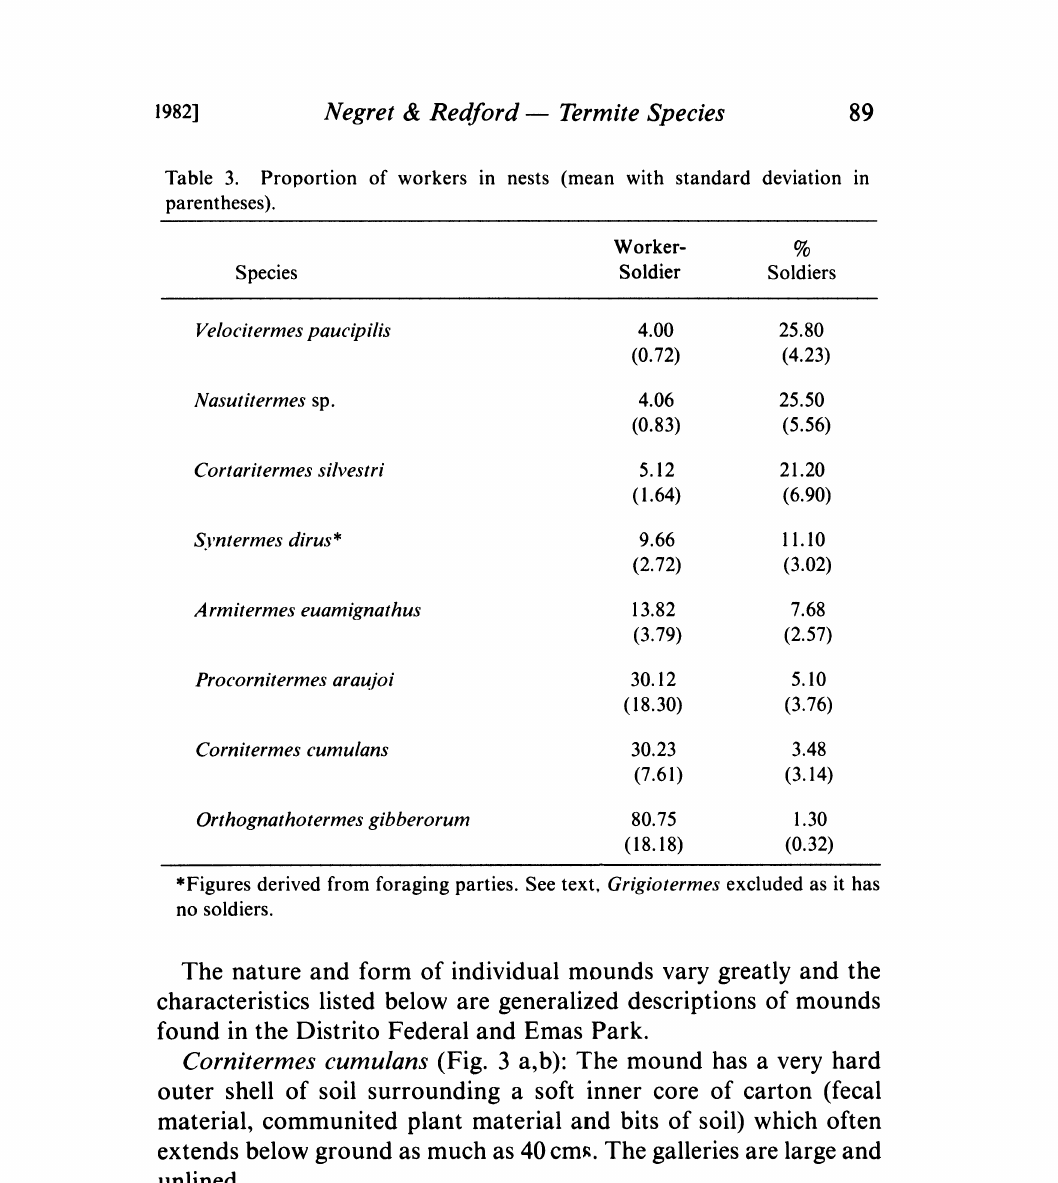
Table 3. Proportion of workers in nests (mean with standard deviation in